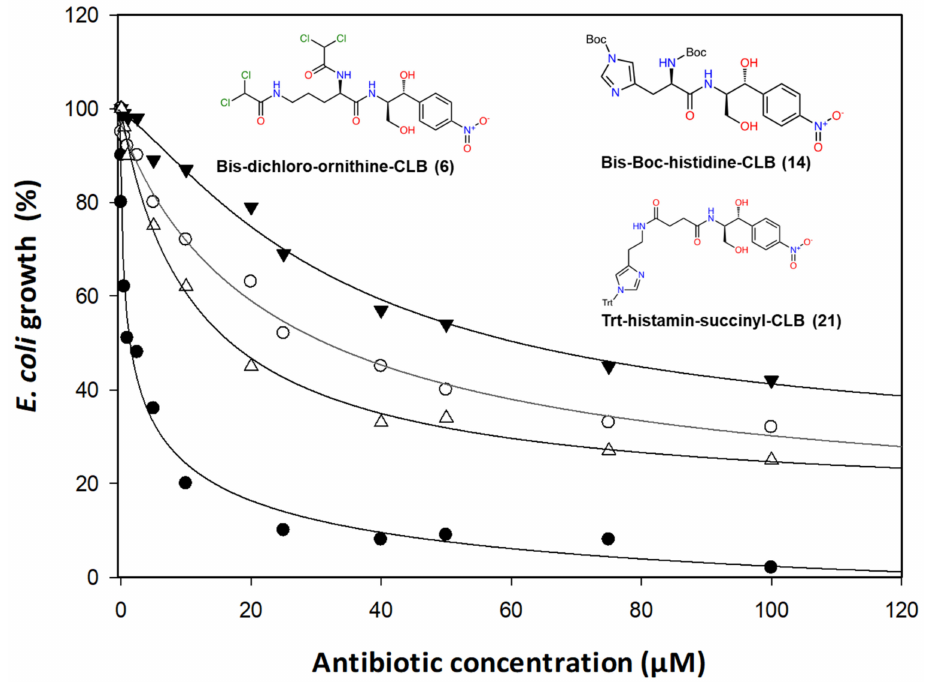
Figure 3. Bacteria E. coli ∆ TolC growth in the presence of CLB derivatives. The bacterial cultures were grown in the presence of either CAM or each derivative at increasing concentrations (0.05 µ M up to 100 µ M). ( • ) Chloramphenicol, ( ∆ ) bis-dichloro-ornithine–CLB (compound 6), ( succinyl–CLB (compound 21), ( (cid:72) ) bis-Boc-histidine–CLB (compound